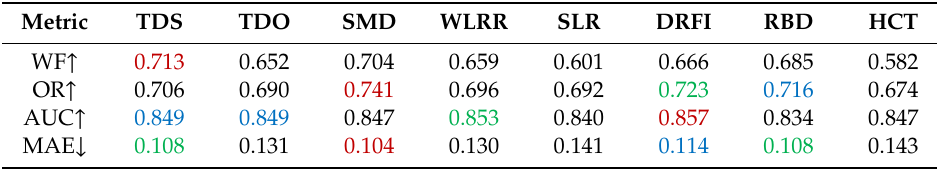
Table 3. Result on MASRA10K dataset in terms of WF, MAE, OR, and AUC. Metric